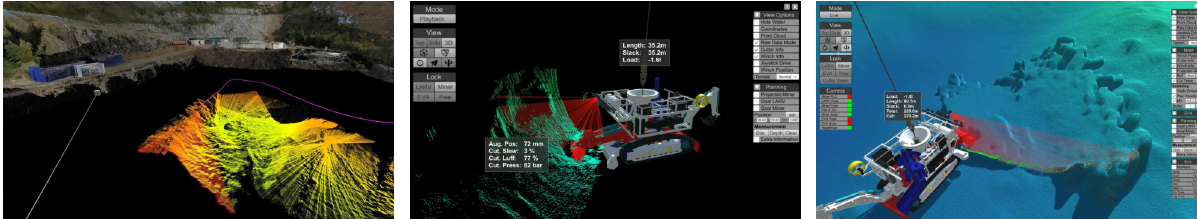
Figure 6. Different views of the VR based human-machine interface. Left: live multibeam data visualization during a survey using the EVA AUV/HROV, middle: mining vehicle with visualization of multibeam sonar scans, right: mining vehicle with updating terrain model using a mechanically panning multibeam sonar. dynamically adjusted using measurements from a tide gauge.